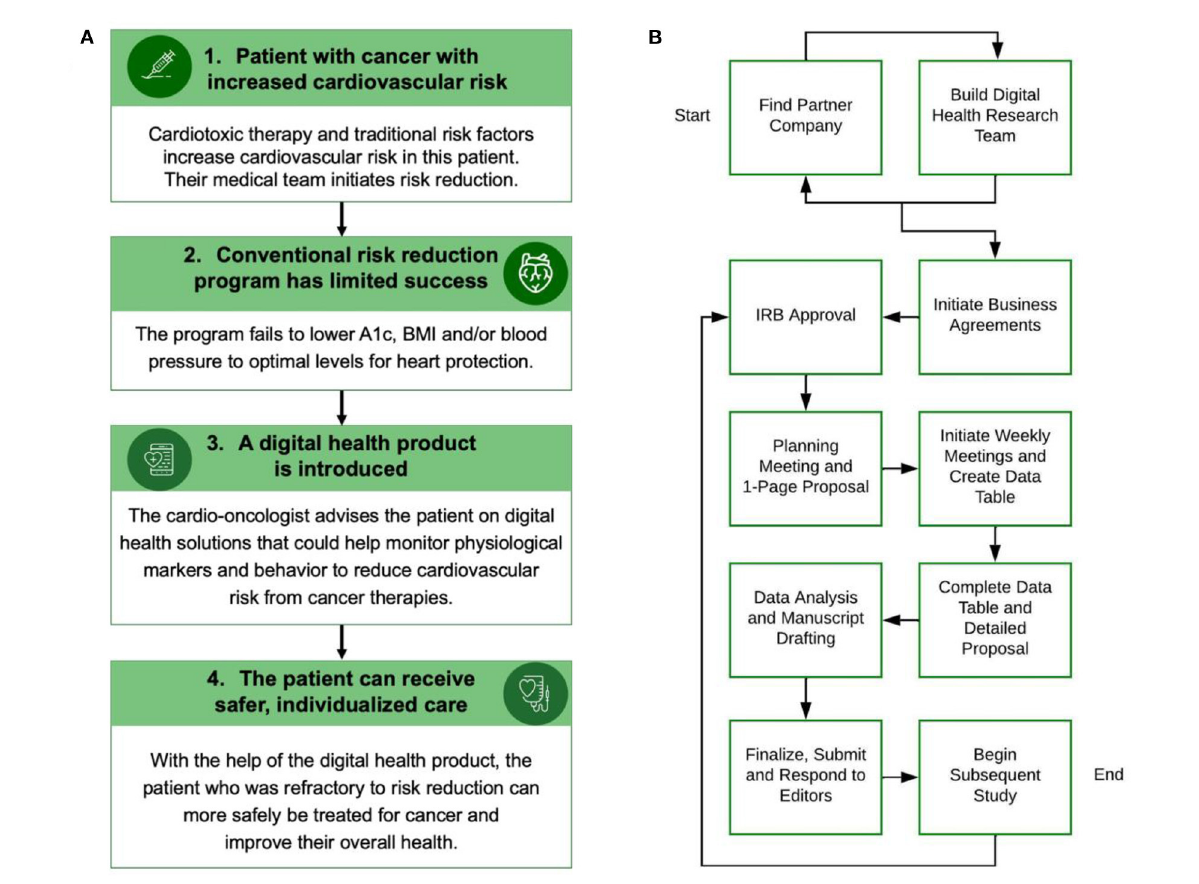
FIGURE1 (A) This figure shows how a cardio-oncologist could integrate a digital health product into risk reduction for a cancer patient. BMI: Body mass index. (B) This flow chart describes ten steps for building a digital health academic-industry collaboration. The process can begin with finding